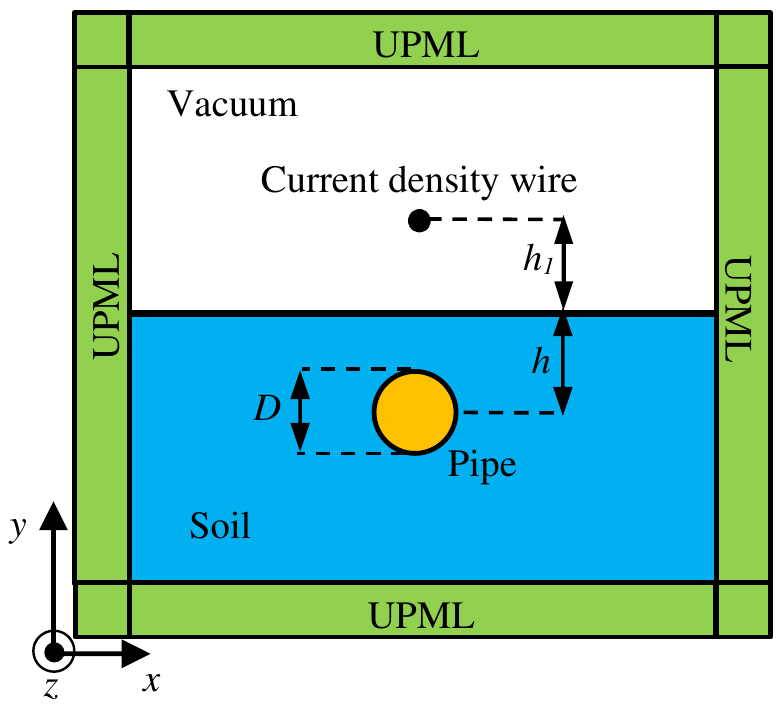
Figure 5. Geometrical sketch of the electromagnetic scattering